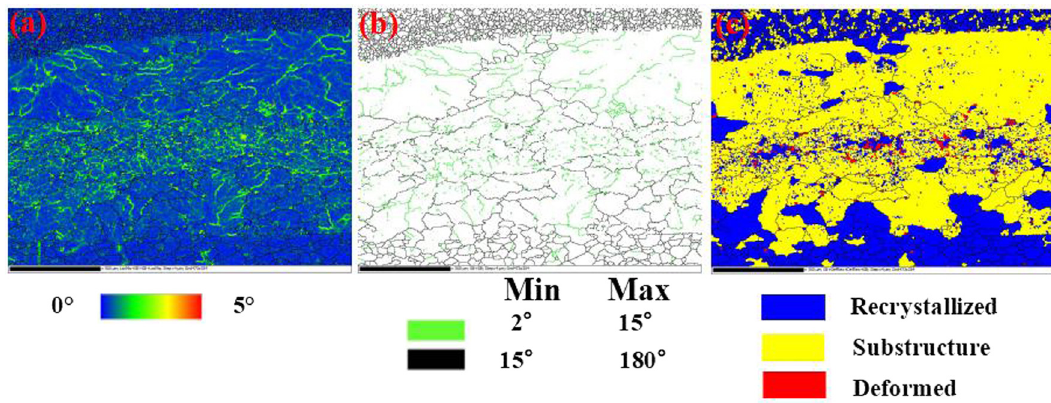
Figure 9: ( a ) KAM diagram, ( b ) grain boundary diagram, and ( c ) recrystallation diagram of brazing joints.